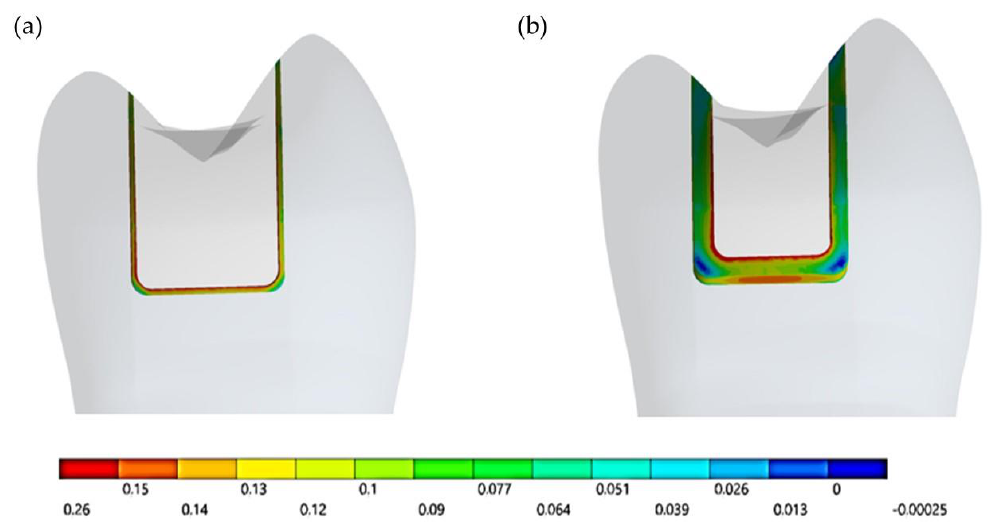
Figure 5. Maximum principal stress in the tooth with ( a ) 100 μm cement thickness model and ( b ) 400 μm cement thickness.